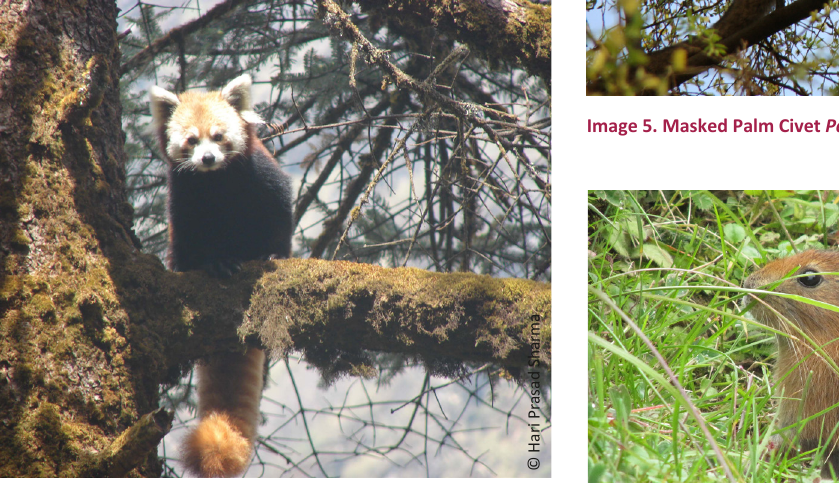
Image 4. Red Panda Ailurus fulgens